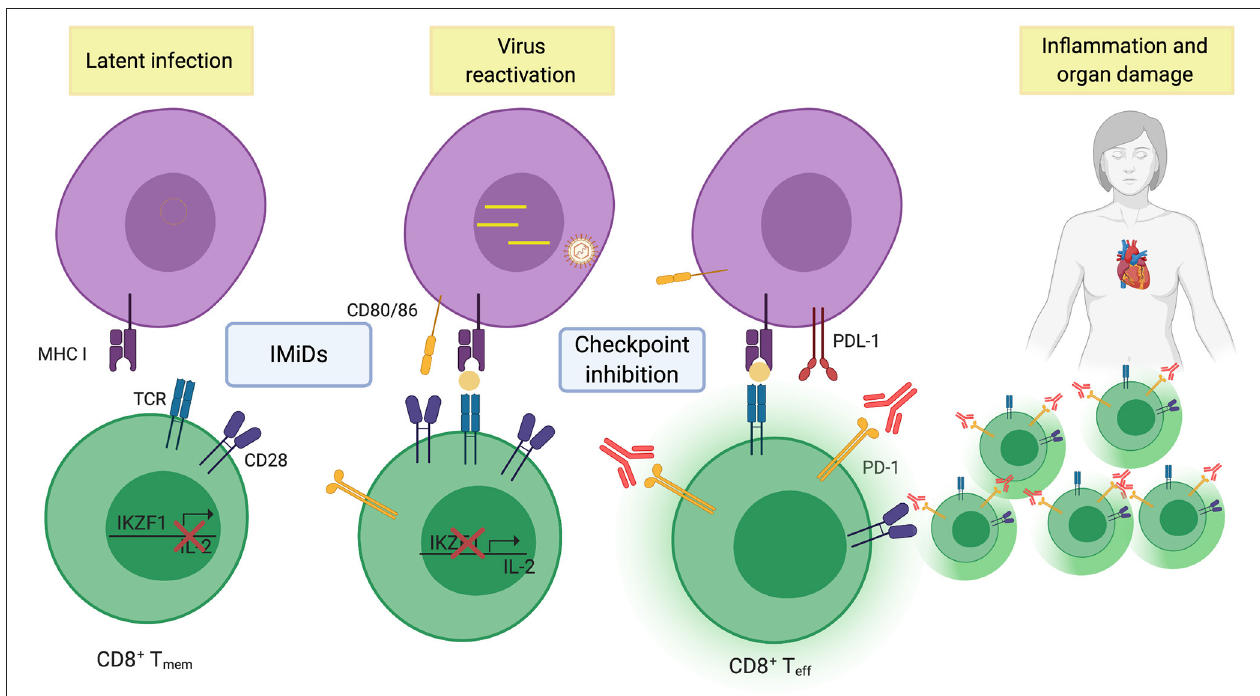
FIGURE 1 | Illustrating re-activation of effector T-cells to viral antigens after combined IMiD and checkpoint therapy. (Created with